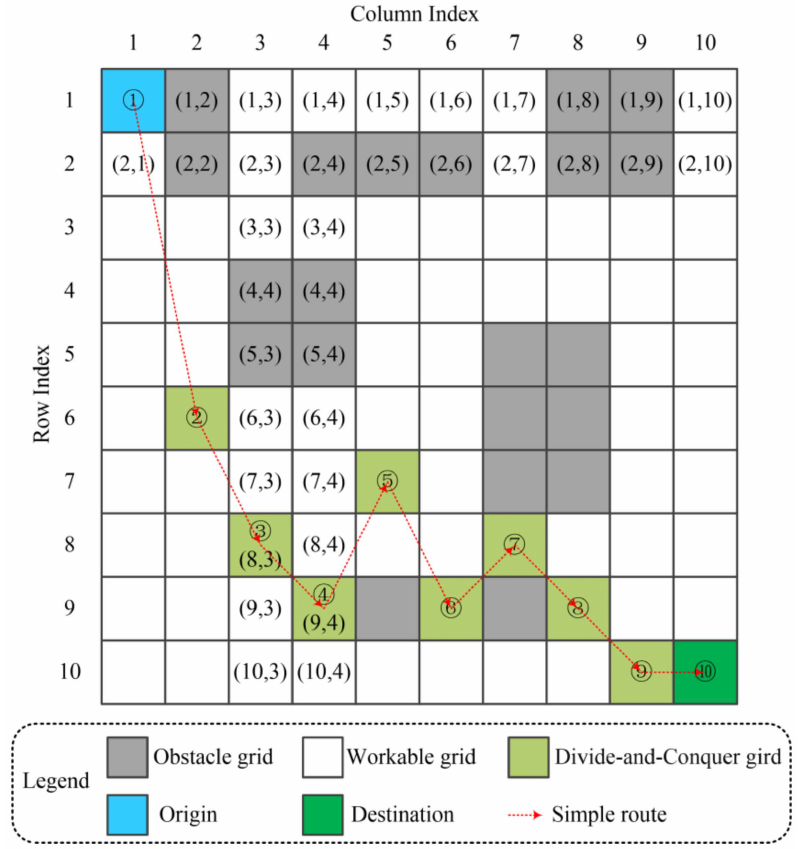
Figure 3. Divide-and-conquer design for